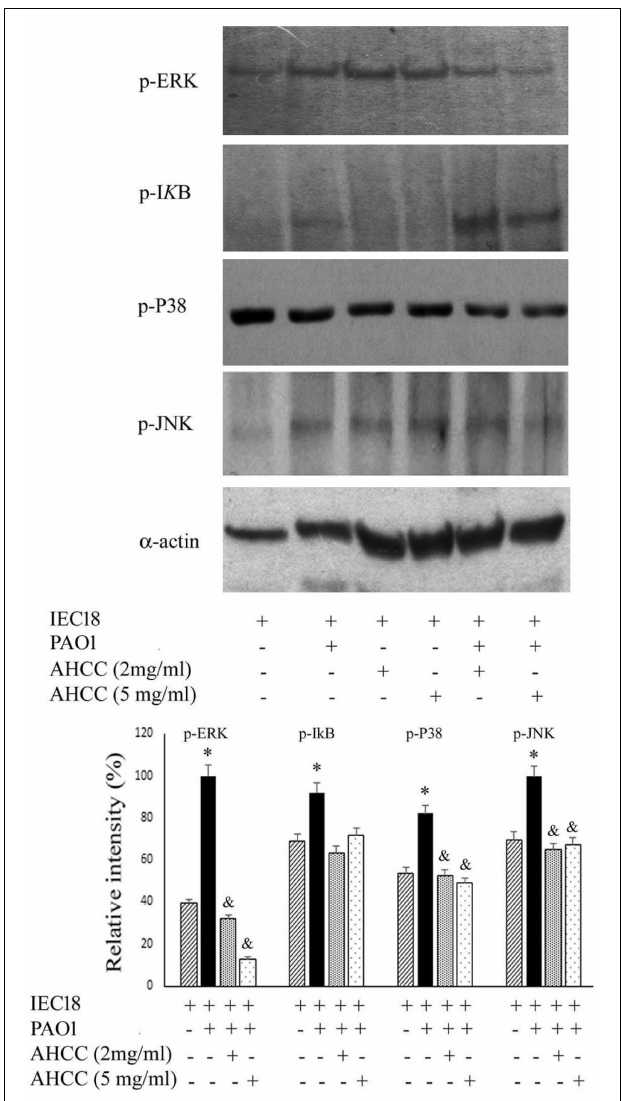
FIGURE 5 | Inflammatory transduction pathways are modulated by AHCC R (cid:13) . Macrophage cells were cultured in the presence of P. aeruginosa in the absence or presence of 2 and 5 mg/mL AHCC R (cid:13) . After 8 h growth western blots were performed using the cell extracts and the corresponding antibody against specifics proteins. The following protein were detected: p-ERK (the phosphorylated form of Extracellular Regulated Kinase), p-P38 (Activated and phosphorylated form of P38 mitogen-activated protein kinases), p-JNK (Jun N-terminal kinases), p-IkB (phosphorylated form). As control, actin was quantified in all samples using α -actin antibody. Shown are duplicate sample in the absence of added effectors and triplicate samples in the presence of AHCC R (cid:13) . * p < 0.05 vs cells without bacteria. (ANOVA followed by least significance